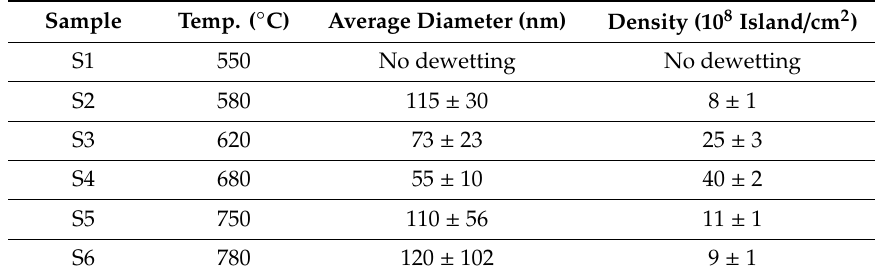
Table 1. a-Ge annealing temperature and nano-island characteristics (diameter and density) of the studied samples. The pristine a-Ge thickness was 15